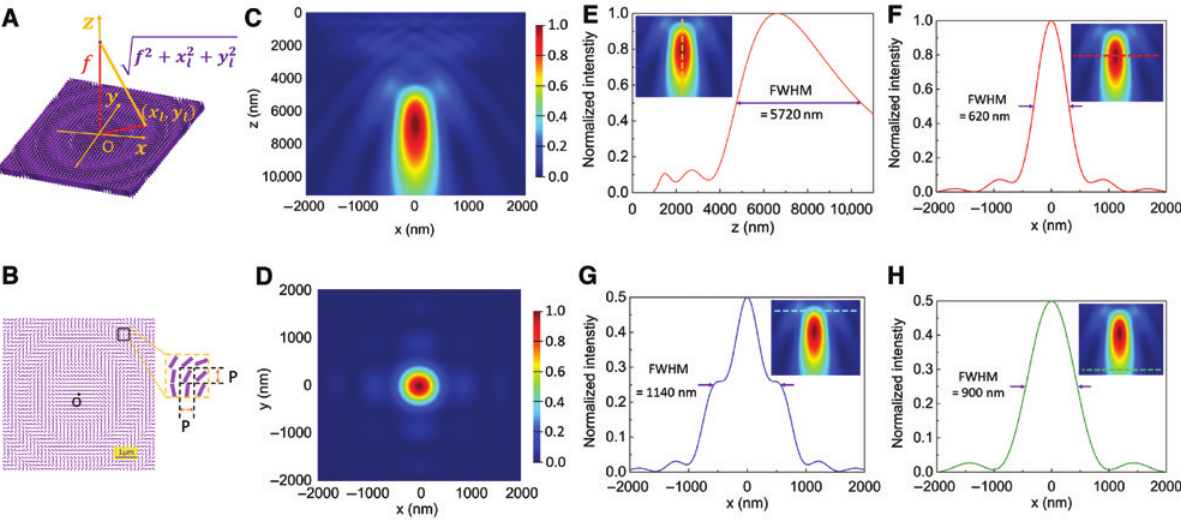
Figure 3: In-plane on-axis focusing characteristics for LCP incidence at UV-375 nm wavelength. (A) Schematic diagram of in-plane on-axis focusing configuration, consisting of an AlN nanorod array, with rotation of different angles. (B) Top view of the metalens; (C) normalized RCP light intensity distribution at the x - z section; (D) normalized RCP light intensity distribution at the x - y section at z = 6.62 μ m. Normalized intensity profile for the focus spot (E) along the z -axis, at x = 0, with the peak located at z = 6.62 μ m; (F) along the x -axis, at z = 6.62 μ m, (G) along the x -axis at z = 4.74 μ m and (H) z = 10.46 μ m. The size of the metalens is 4 μ m × 4 μ m, containing 23 × 23 AlN nanorods in total. The NA is 0.196. The top surface is located at z = 0. The insets inside (E)–(H) are the enlarged view of the focal spot in (C), where the colored lines denote the position of the data extracted from the focal